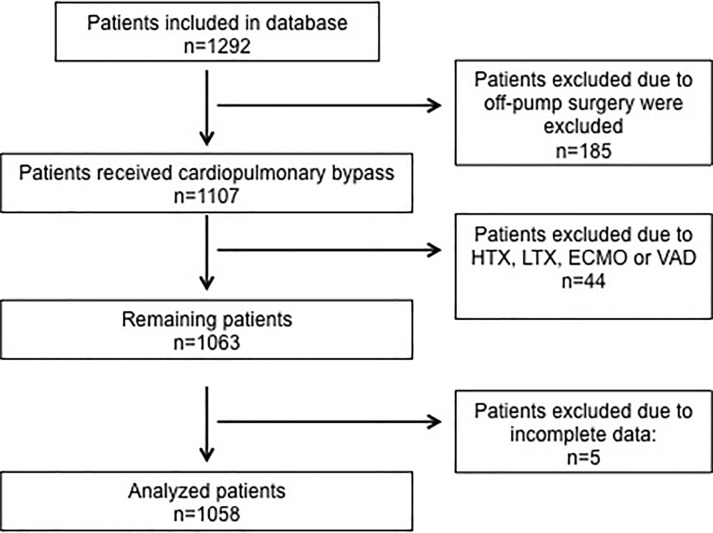
Study flow chart.HTX: heart transplantation, LTX: lung transplantation, ECMO: extracorporeal membrane oxygenation, VAD: ventricular assist device.